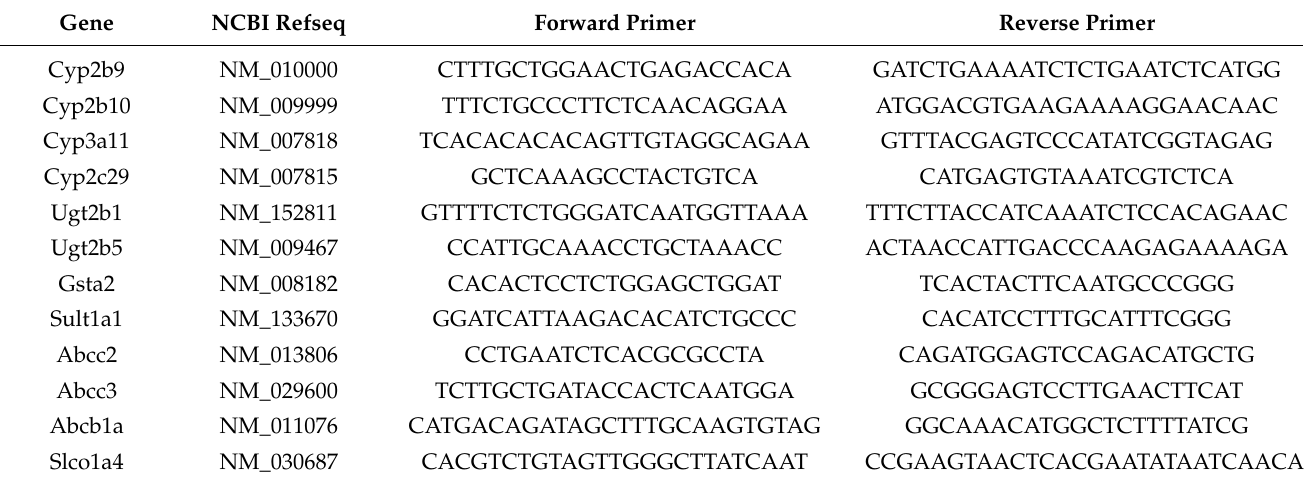
Table 1. SYBR Green assay primers used for gene expression analysis by RT